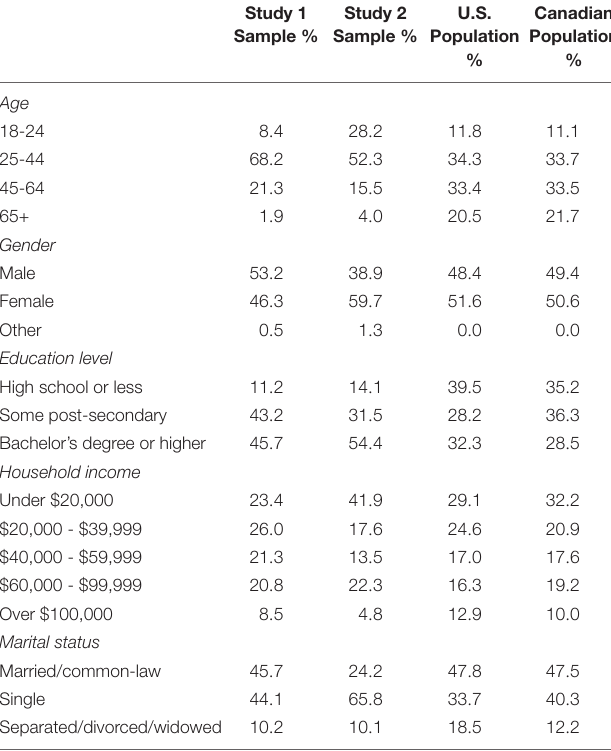
TABLE 1 | Demographic characteristics of the samples in